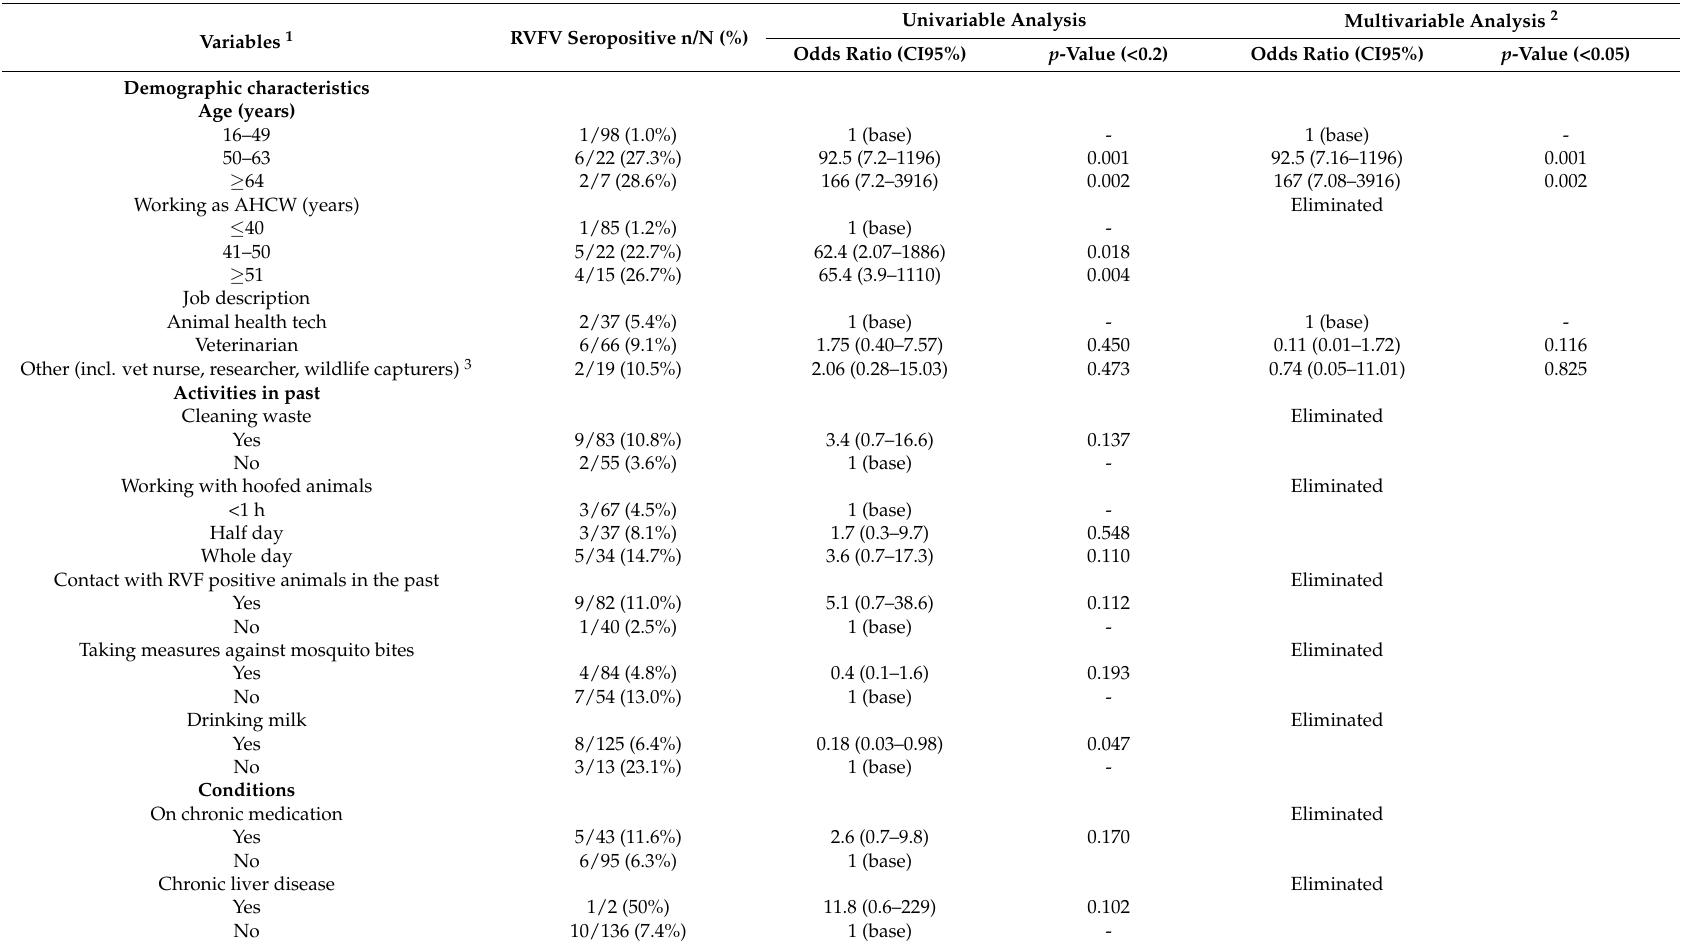
Table 2. Univariable and multivariable logistic regression analyses for potential risk factors for RVFV seropositivity in veterinarians and associated professions (AHCWs) in the study area of South Africa during